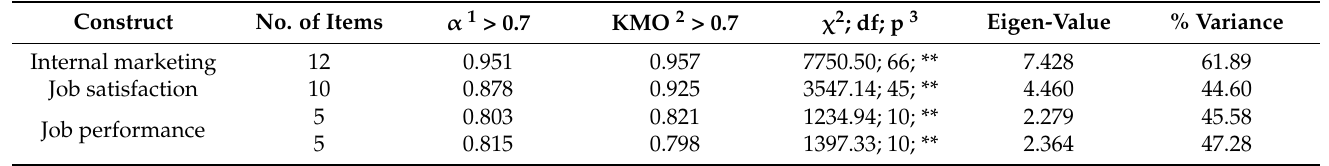
Table 2. Results of data validity and reliability regarding collected